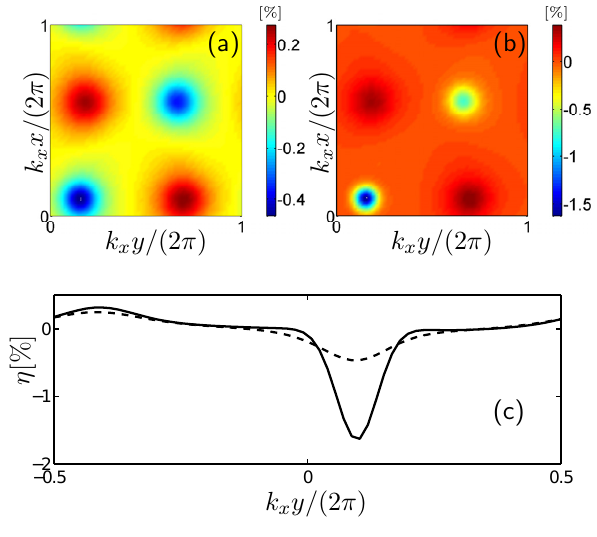
Fig. 3. Panels (a) and (b) show η in a plane perpendicular to B 0 at t = 0 . 72s and t = 0 . 73s, respectively. Panel (c) shows η = η(y) for k x x/( 2 π) = 0 . 1. The dashed (solid) line corresponds to t = 0 . 72s ( t = 0 .